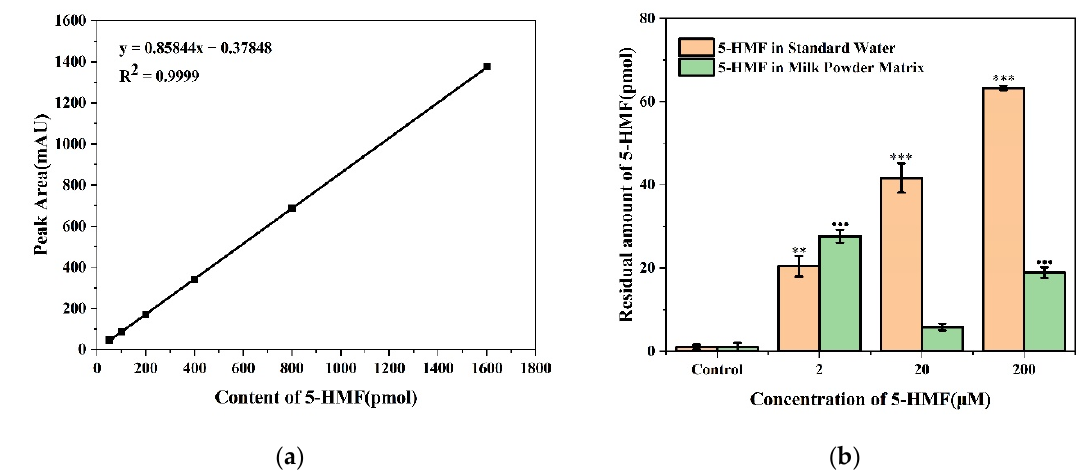
Figure 7. HPLC detection of 5-HMF residues in each group of zebrafish larvae after 120 h exposure. ( a ) The standard curve of 5-HMF after the addition of standard samples; ( b ) The residues of 5-HMF in different matrices for each concentration group. ** p < 0.01, *** or ●●● p < 0.001 vs. control.